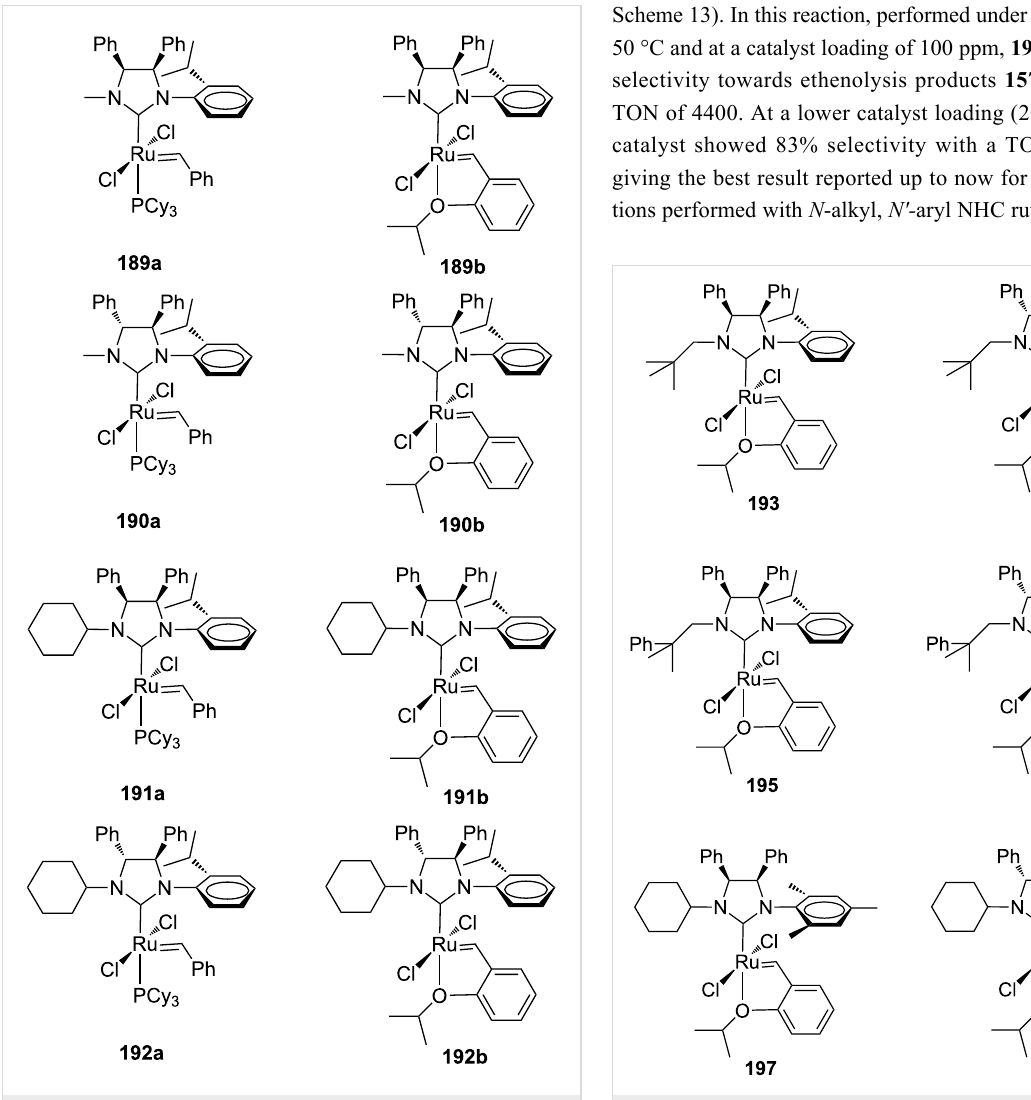
Figure 34: N- Alkyl, N’ -isopropylphenyl NHC ruthenium complexes with syn ( 189 , 191 ) and anti ( 190 , 192 ) phenyl groups on the backbone.